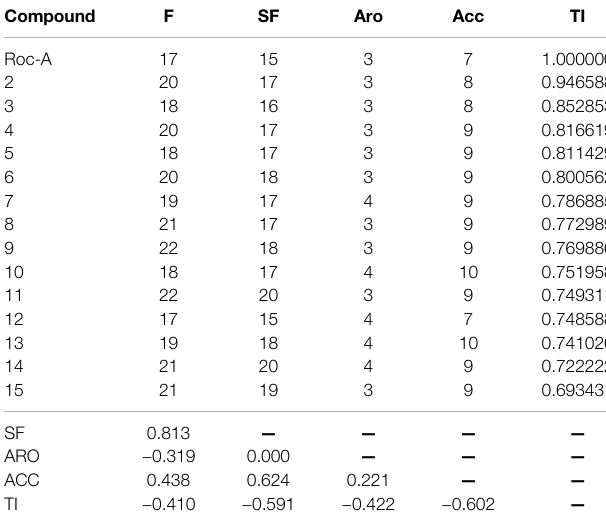
TABLE 5| Pharmacophoricfeaturesforeach compound ofthetraining set andtheir TI (Tanimoto Index) similarity values in relation to Roc-A (pivot molecule). Additional matrix showing pearson ’ s correlation (p) values in between pharmacophoric features and TI values. Compound